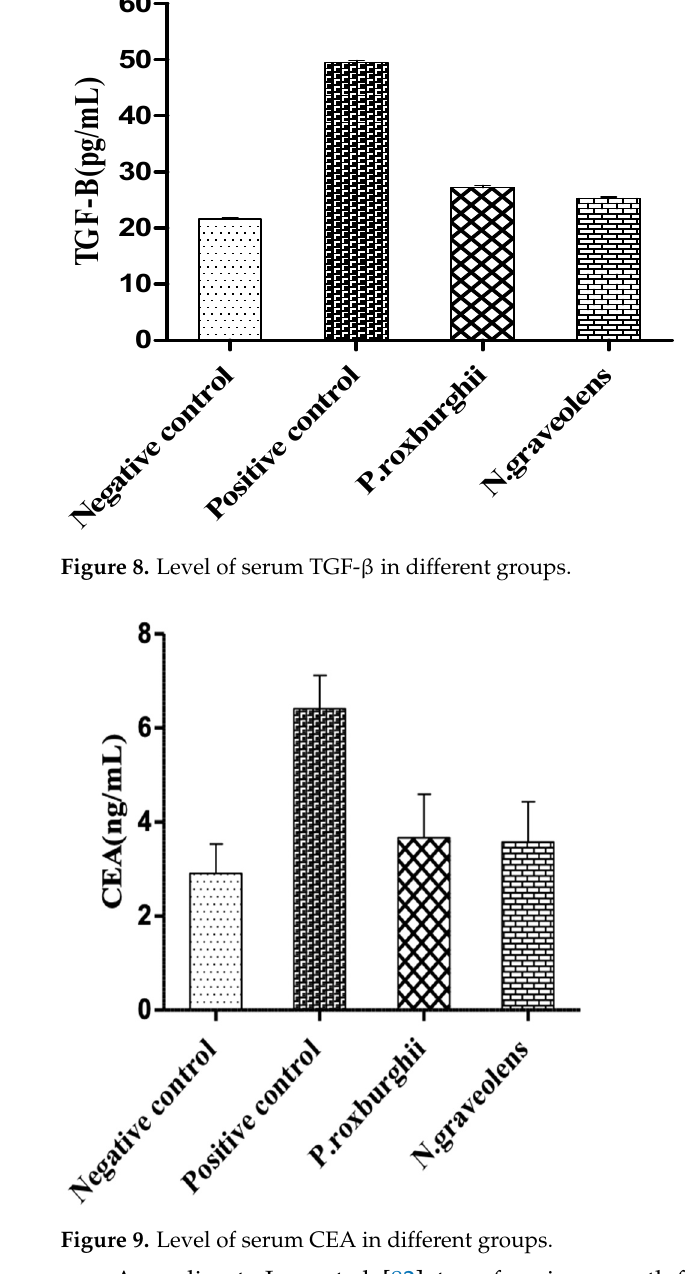
Figure 10. Level of serum CA19-9 in different groups. According to Jung et al. [82], transforming growth factor-beta (TGF- β ) is a signaling pathway for controlling cell growth, differentiation, multiplication, homeostasis, and apoptosis. Although TGF- β is responsible for signaling the arrest of epithelial cell growth N e ga t i v e c o n t r o l P o s i t i v e c o n t r o l P . r ox bu r g h ii N . g r av e o l e n s 0